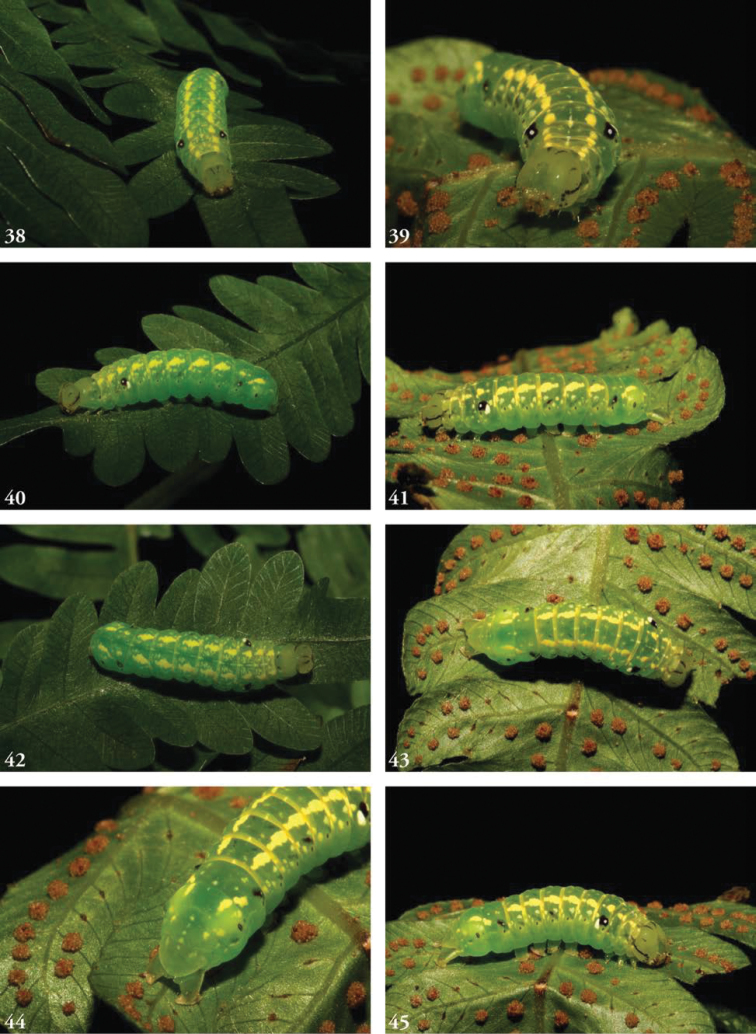
Larvae, green, penultimate instar. 39 05-SRNP-48764 DHJ408129 40USNMENT01463798, 10-SRNP-44267 ♀ DHJ478607 41 05-SRNP-48764 DHJ408127 42USNMENT01463798, 10-SRNP-44267 ♀ DHJ478603 43USNMENT01463798, 10-SRNP-44267 ♀ DHJ478606 44USNMENT01463798, 10-SRNP-44267 ♀ DHJ478605 45USNMENT01463798, 10-SRNP-44267 ♀ DHJ478608 46 05-SRNP-48764 DHJ408128.